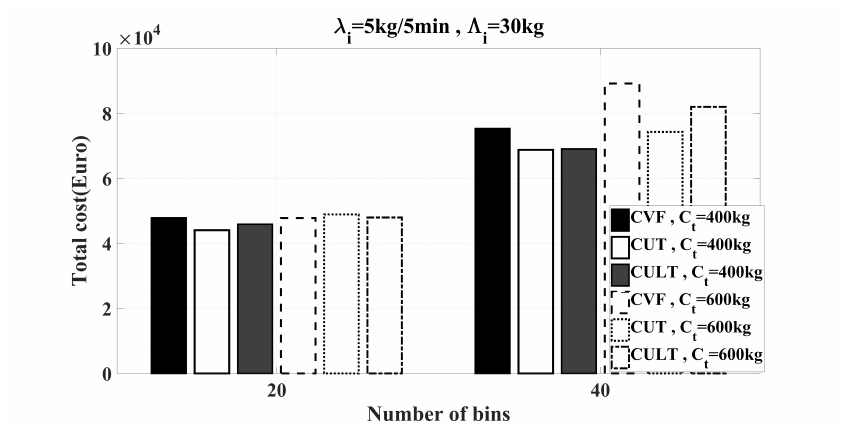
Figure 10. Cost: bin count when the bin capacity was increased.